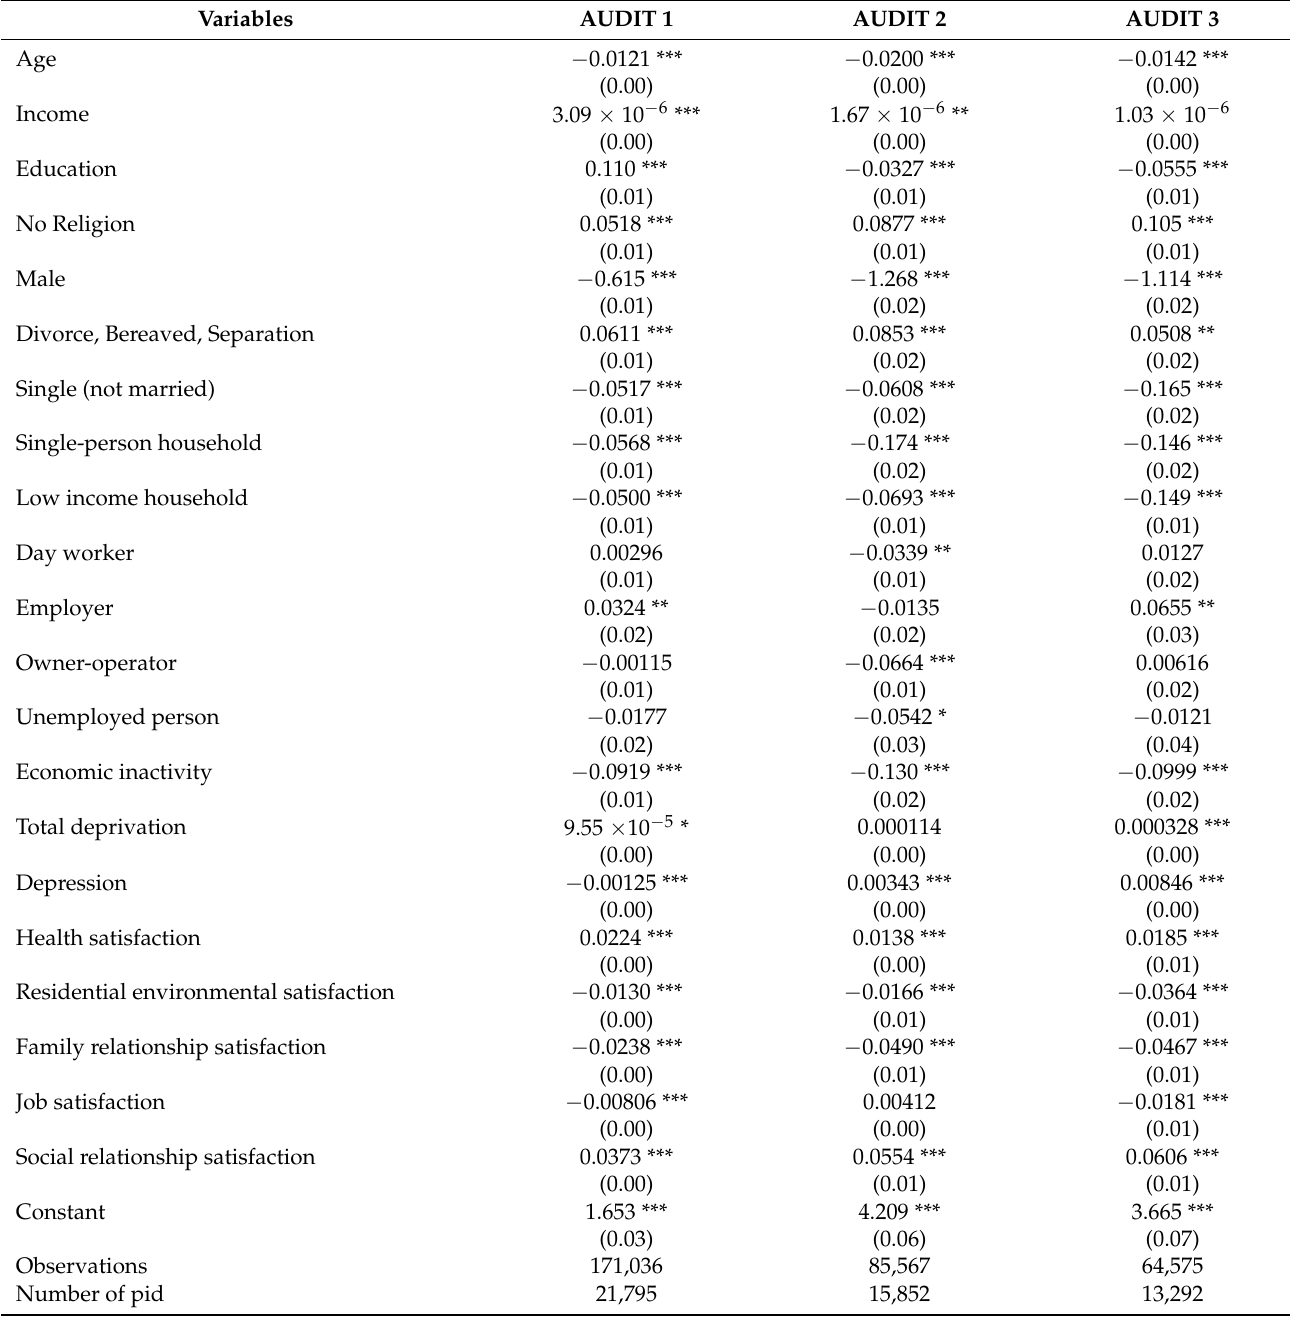
Table 4. Results of panel